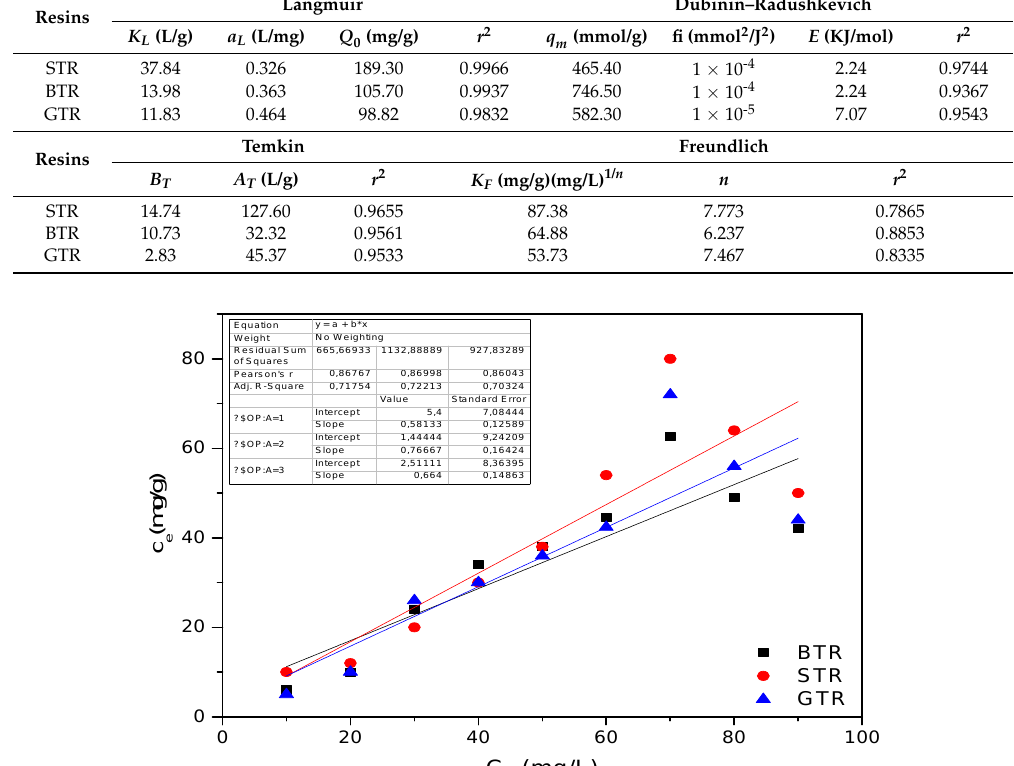
Figure 7. Plot of the equilibrium quantity of Pb 2 + adsorbed with response to concentration by the three resins.